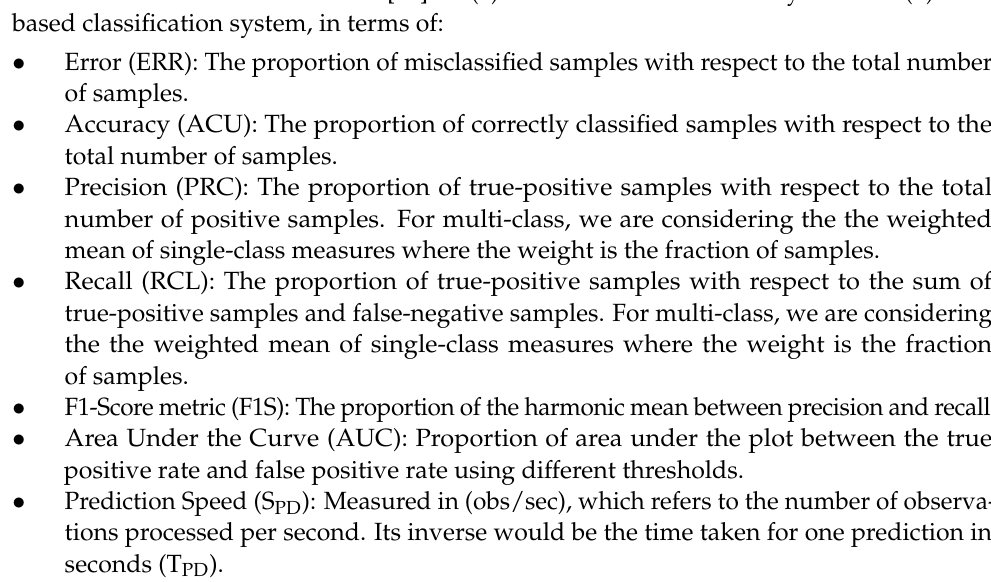
Figure 12. General form of Confusion Matrix with corresponding metrics (Precision, Recall, Accu- racy).